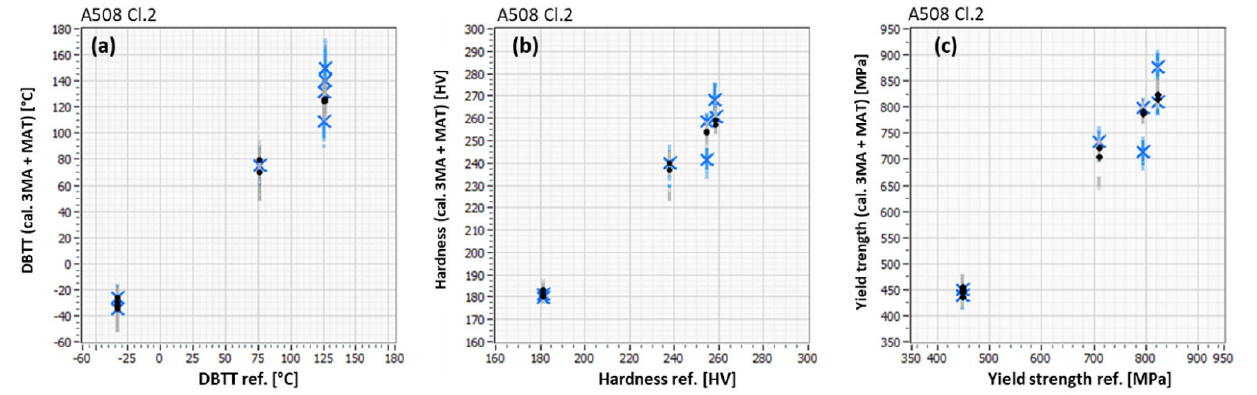
Figure 17. Prediction of DBTT ( a ), mechanical hardness ( b ), and yield strength ( c ) for A508 Cl.2 material using combined data from 3MA-X8 and MAT methods.